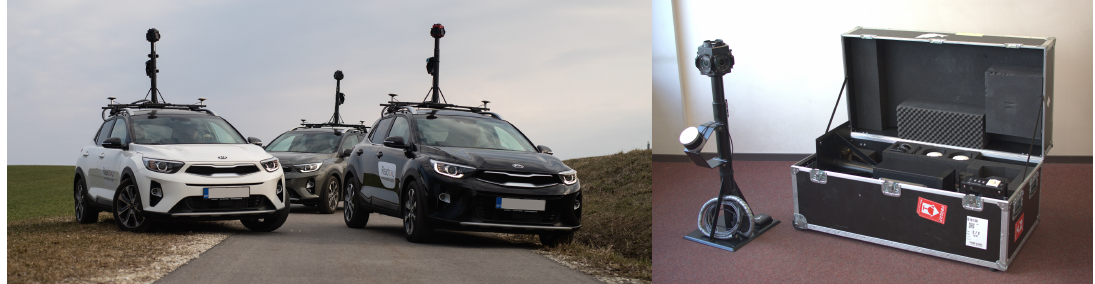
Figure 1. Left: Vehicles carrying the MMS. Right: Ladybug 5+ Imaging